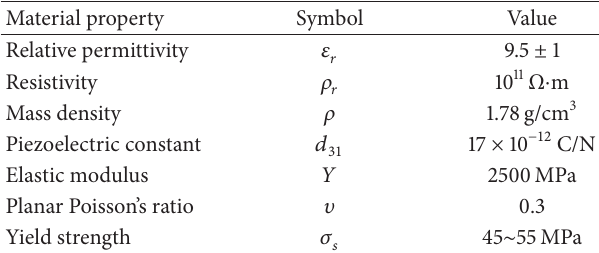
Table 1: Properties of the PVDF